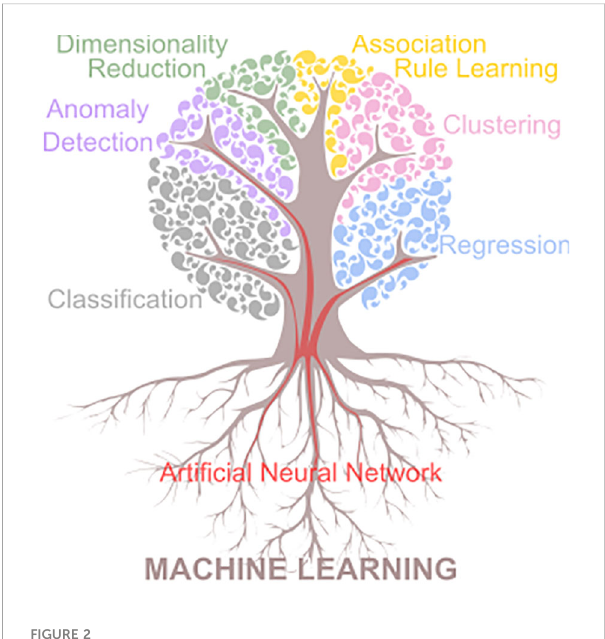
FIGURE 2 Taxonomy of machine learning according to the type of task to be